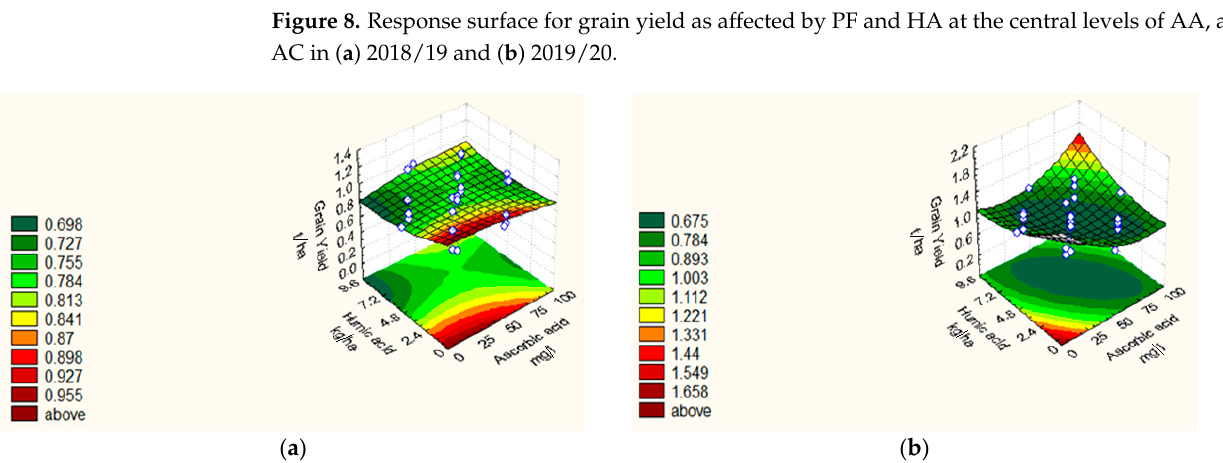
( b ) Figure 10. Response surface for grain yield as affected by AC and HA at the central levels of AC and HA in ( a ) 2018/19 and ( b ) 2019/20. 4. Discussion The central composite design, as proposed by [33], is utilized to quantitatively eluci- date the importance of the studied factors and their linear interaction for the various stud- ied characteristics. Hence, the factor that reveals significant main and interaction effects on the studied characteristics should be considered more important than the other factors that show relatively fewer significant effects. Seasonal variations should be taken in con- sideration, where the factors that show significant effects in both seasons are considered more important than those showing significance in only one season. Concerning forage yield and quality characteristics, the results indicated that delaying cutting beyond 98 DAS led to an increase in NDF (25%), ADF (43%), and ADL (64%), in addition to an in- crease in dry forage yield (DFY) by 64% and non-fiber carbohydrates (NFC) by 12%. On the other hand, a pronounced decrease of 59% in crude protein (CP) was observed with delayed cutting. These findings were in agreement with those reported by [23,37,38], who reported that cutting the crop at an advanced age increased the DFY. The increase in DFY may be attributed to the increase in the stem component of the forage and the reduction in the leaf component, where stems are higher in dry matter content than leaves, thus contributing to the DFY of the produced herbage [22]. In addition, as the plant grows the photosynthetic activity increases leading to higher biomass production [39]. Similarly, fi- ber fractions (NDF, ADF, and ADL) increased with delayed cutting, which may be as well attributed to the increase in the stem component of the older plants than the leaf compo- nent [23]. Furthermore, while the plant matures the contents of water-soluble carbohy- drates in the leaves and stems decrease, which is associated with an increase in their con- tent from the different fiber fractions [40]. Non fiber carbohydrate content is another